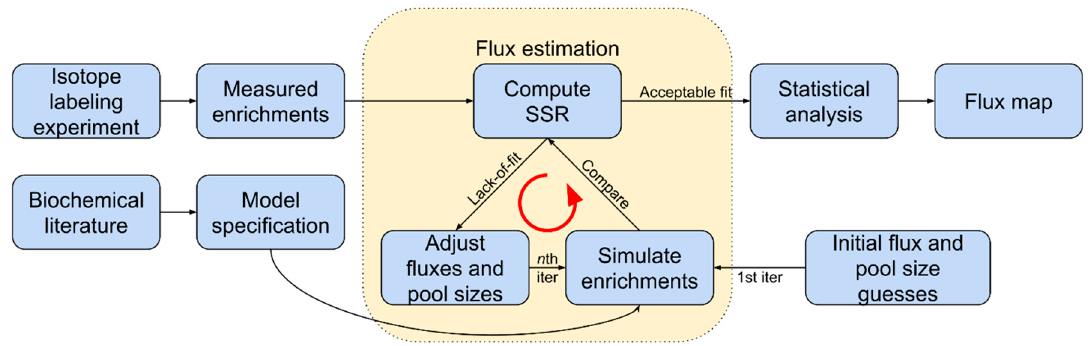
Figure 4. Simplified INST-MFA workflow to estimate flux. Software, such as INCA and OpenMebius, is used in several steps. Fluxes and pool sizes are initially guessed and then adjusted in each iteration, converging upon a flux map that fits measurements of metabolism during the ILE. Adapted with permission from ref. [92]. Copyright 2018 Elsevier